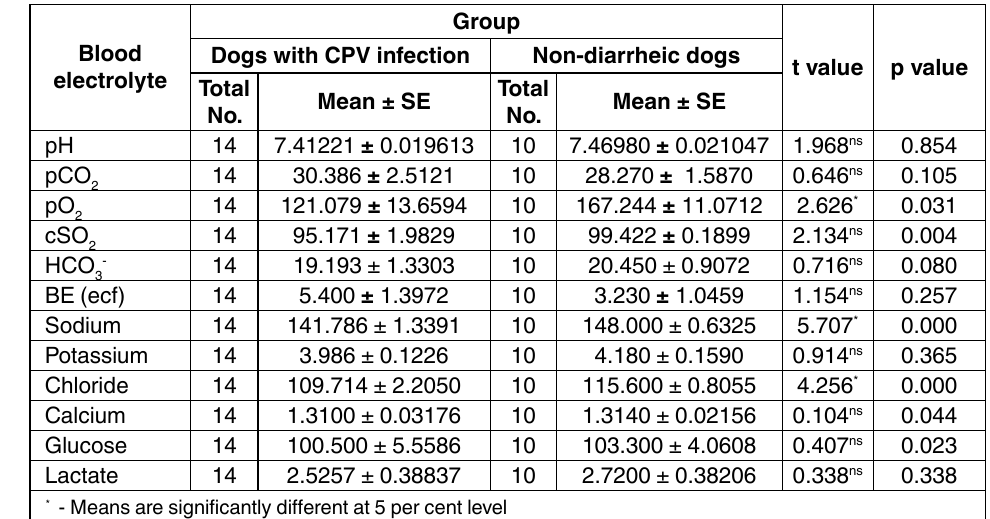
table 7. Comparison between blood gas and electrolyte values of CPV infected and control dogs Blood